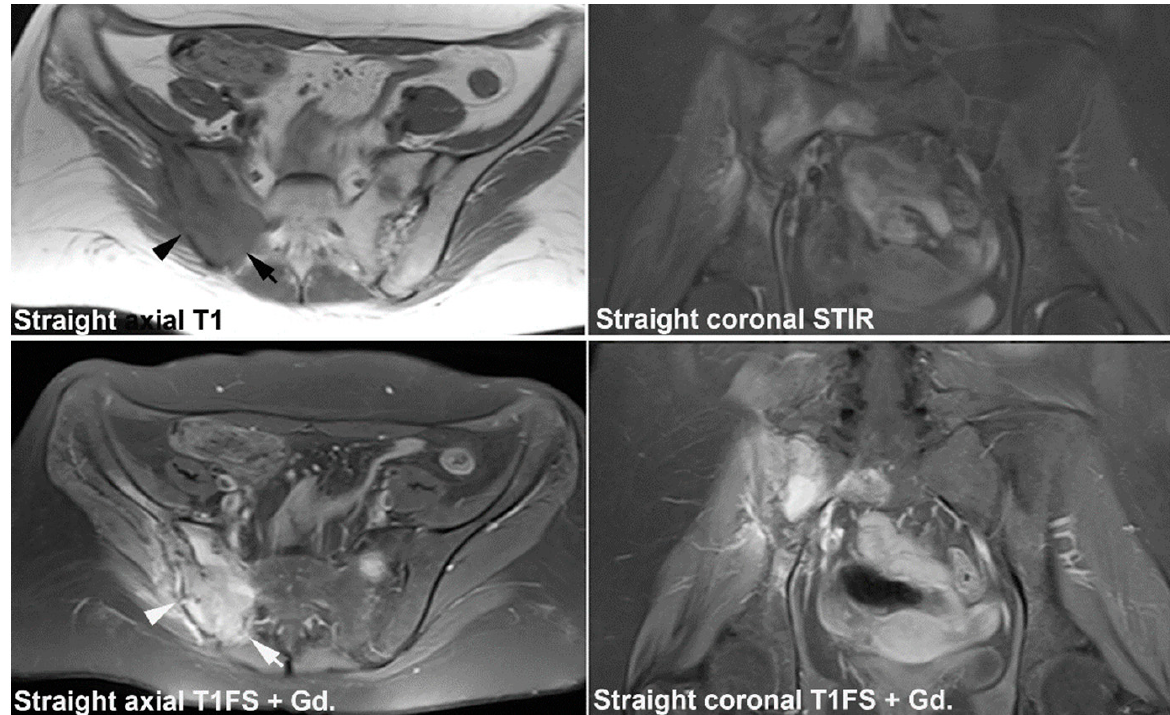
Figure 31. Malignant tumor , MRI in a 20-year-old woman, straight axial T1 and coronal STIR (upper image row), and postcontrast T1FS sequences in the same scan planes (lower image row). Osseous destruction of the iliac and sacral bone at the right SIJ is seen with fracture lines in the ileum (arrowheads) and a solid enhancing soft tissue mass posteriorly (arrows). Biopsy confirmed malignancy (osteosarcoma).